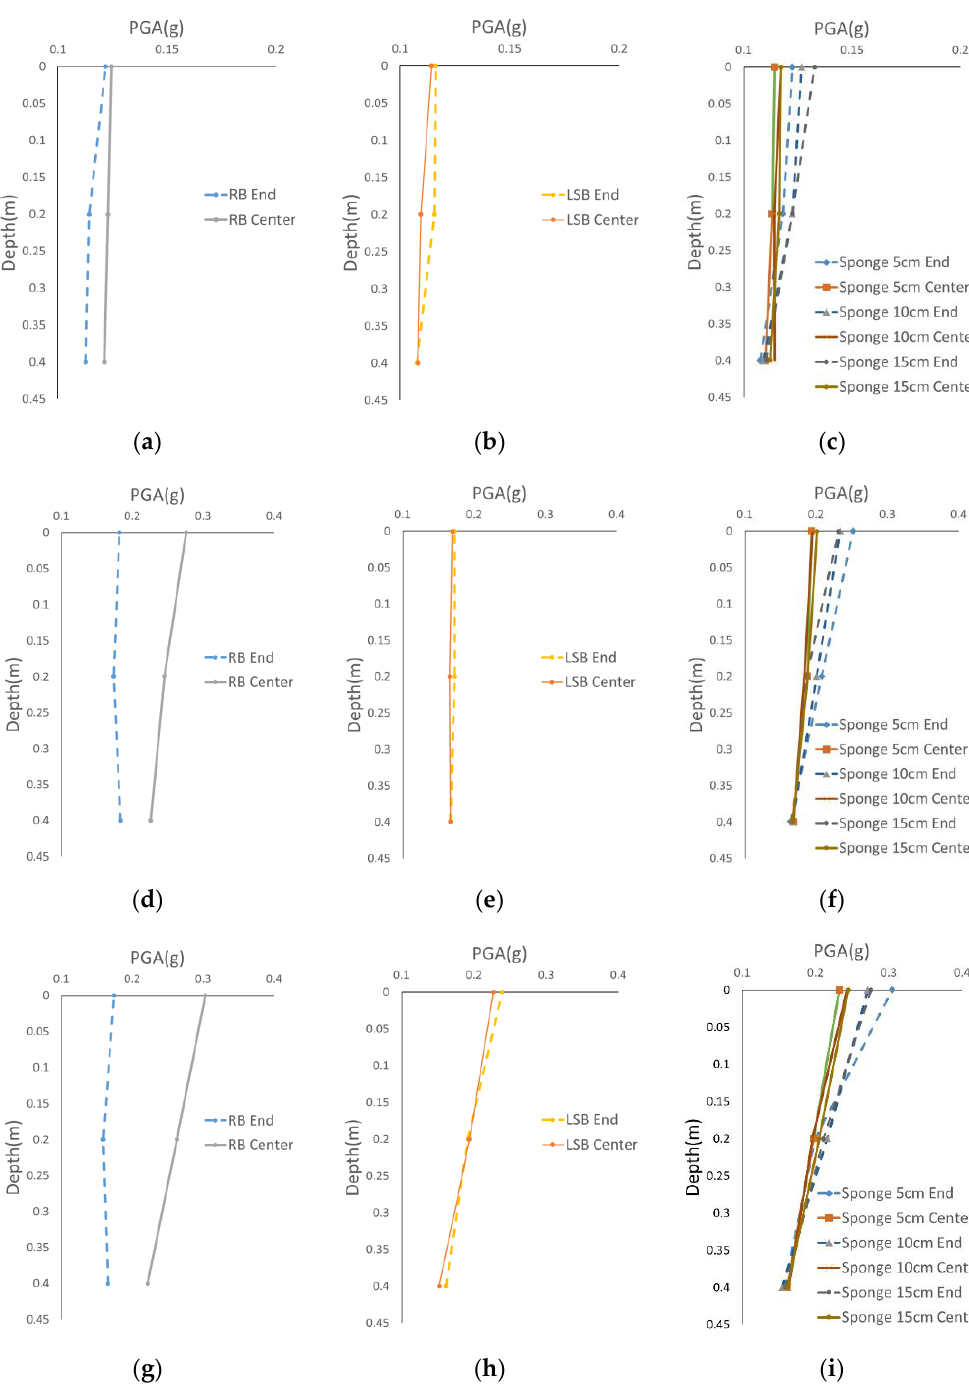
Figure 9. Peak ground acceleration by input motions: ( a ) PGA of RB by Sine wave 2 Hz, 0.1 g; ( b ) PGA of LSB by Sine wave 2 Hz, 0.1 g; ( c ) PGA of sponge by Sine wave 2 Hz, 0.1 g; ( d ) PGA of RB by Sine wave 2 Hz, 0.154 g; ( e ) PGA of LSB by Sine wave 2 Hz, 0.154 g; ( f ) PGA of sponge by Sine wave 2 Hz, 0.154 g; ( g ) PGA of RB by Artificial seismic wave; ( h ) PGA of LSB by Artificial seismic wave; ( i ) PGA of sponge by Artificial seismic wave.